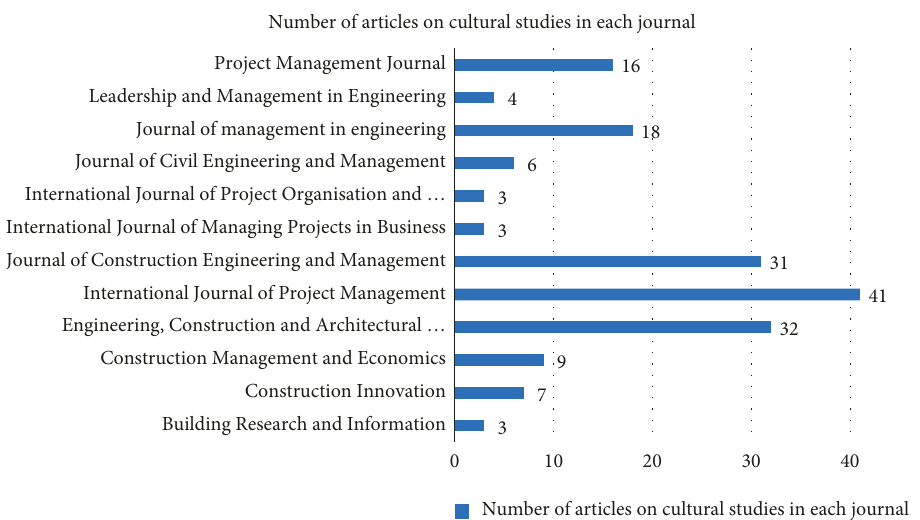
Figure 2: Number of articles published in top international periodicals on culture from 1989 to